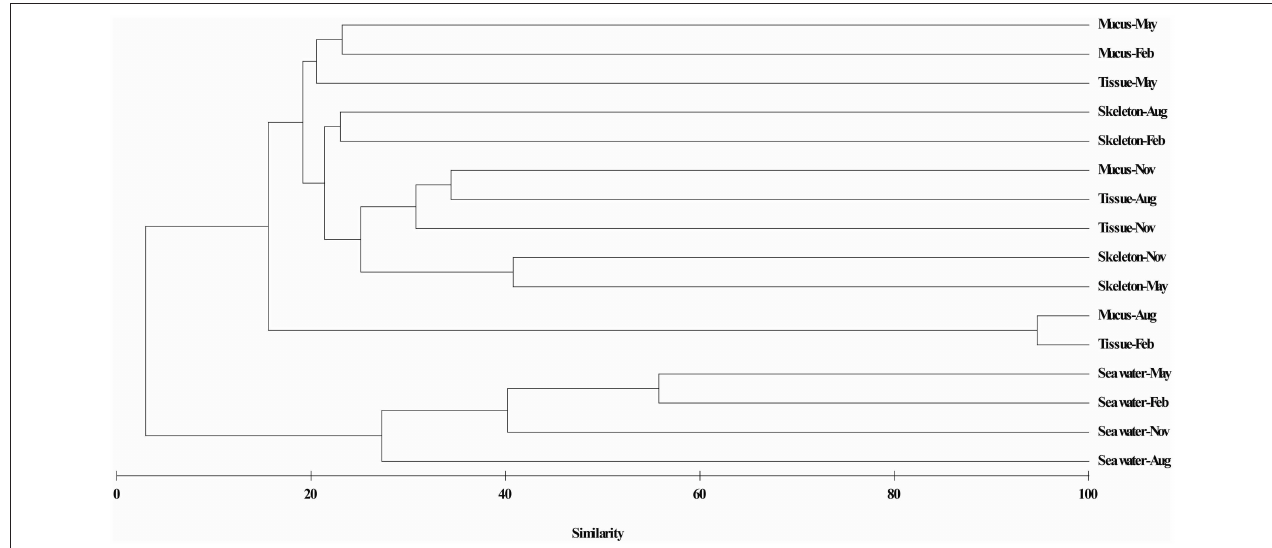
FIGURE 3 | Hierarchical cluster analysis of actinobacteria communities associated with P. lutea . Clustering was based on Bray-Curtis similarity estimated from the OTUs matrix by using the complete linkage